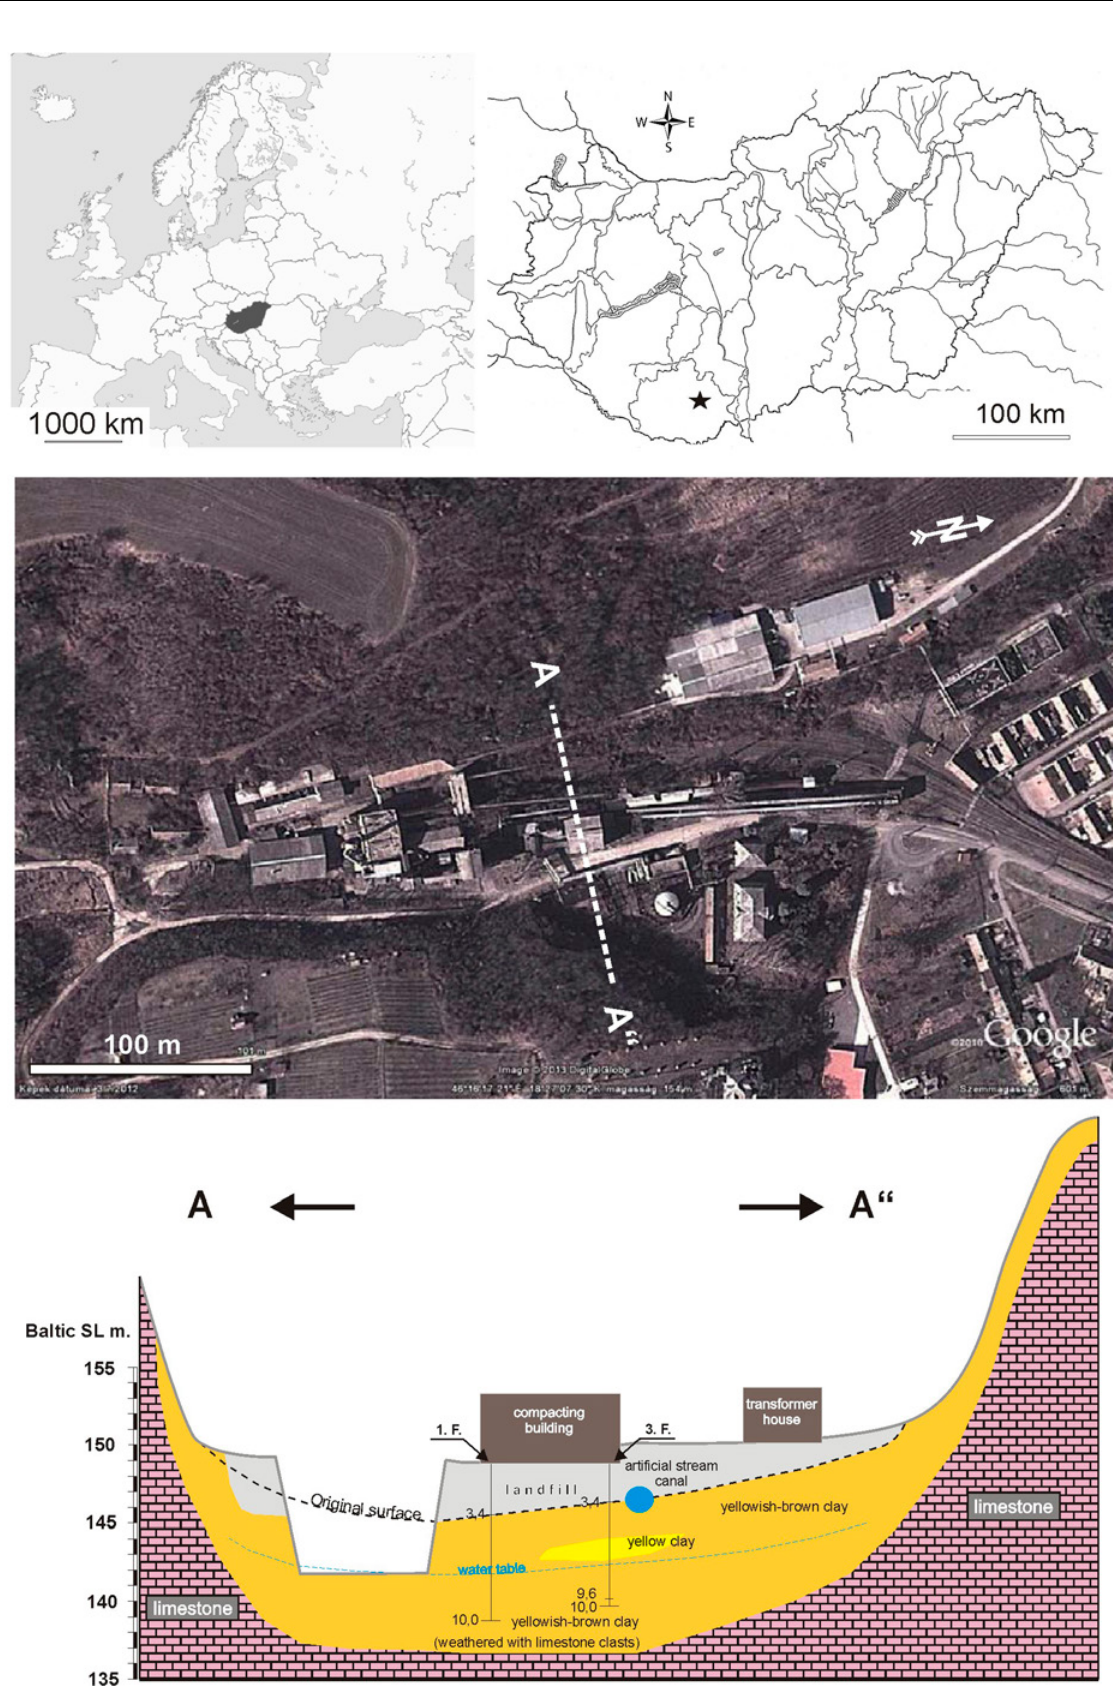
Fig. 1. The former industrial zone (briquette manufactory) and its surrounding before the demolition